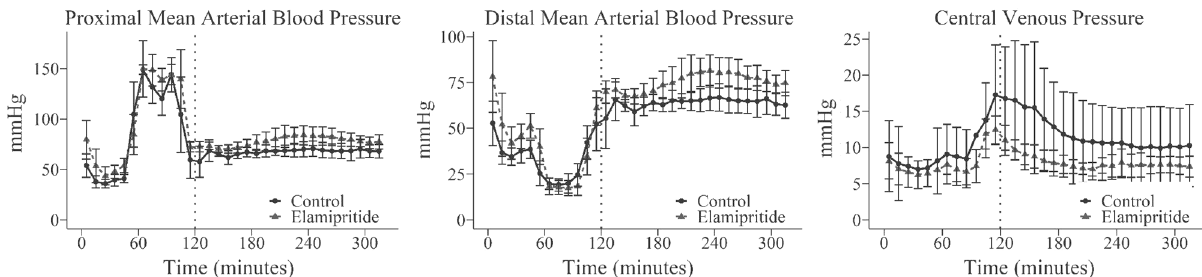
Figure 2. Proximal arterial, distal arterial, and central venous blood pressure over time. 10-min bins are represented as mean with standard deviation as error bars. The dotted vertical line denotes the removal of the aortic balloon and the start of the critical care